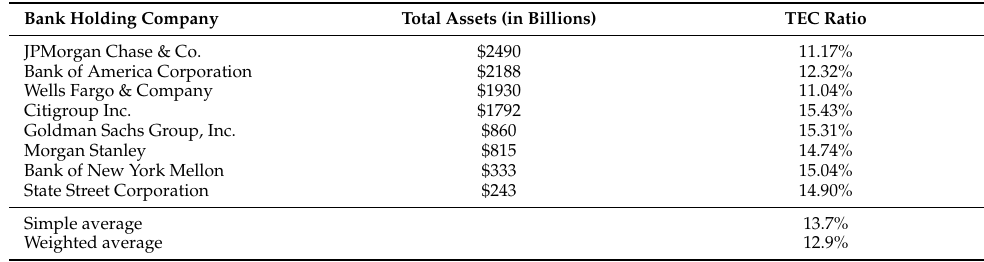
Table 4. US GSIBs’ 2016 tangible equity capital (TEC)